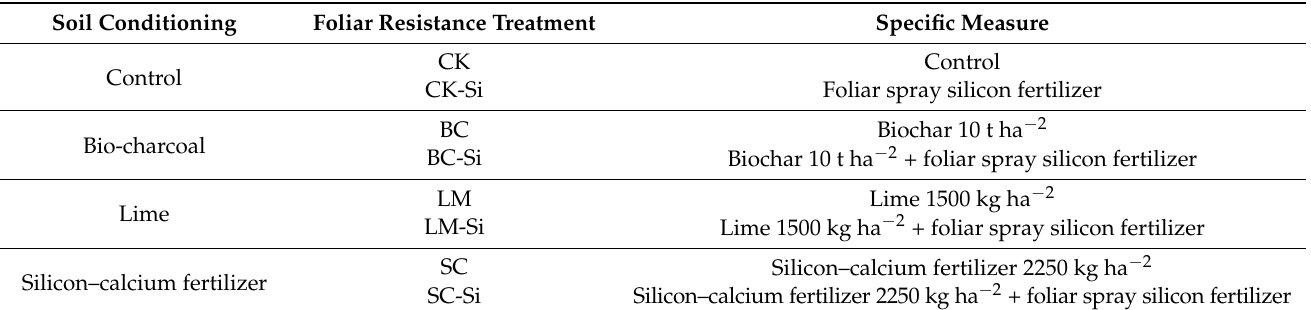
Table 1. Trial treatments and specific